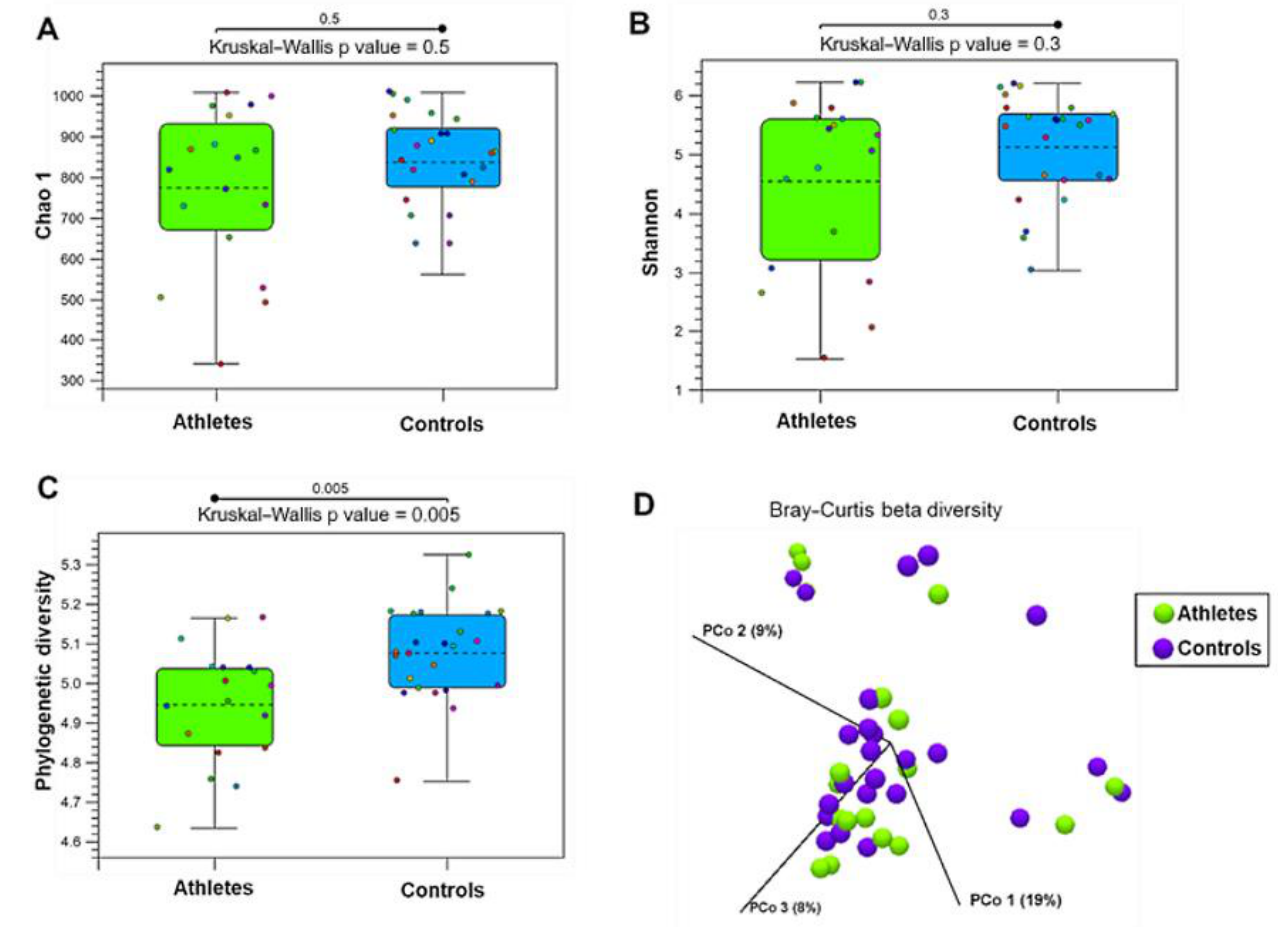
Figure 1. The diversity of the gut microbiota in the athletes ( n = 27) and controls ( n = 27). ( A ) Chao1, a measure of alpha-diversity indicating species richness. ( B ) Shannon index, a measure of alpha- diversity indicating species diversity. ( C ) Phylogenetic diversity. ( D ) Principal coordination (PCo) plot of beta-diversity analyzed by Bray–Curtis distance.